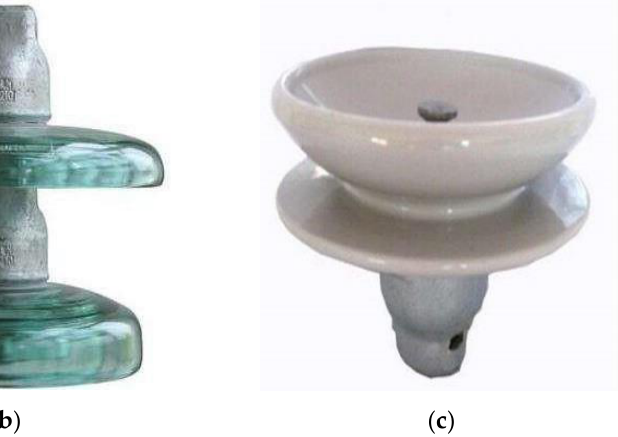
Figure 3. Three common types of insulators: ( a ) FXBW; ( b ) LXY; ( c ) XWP.